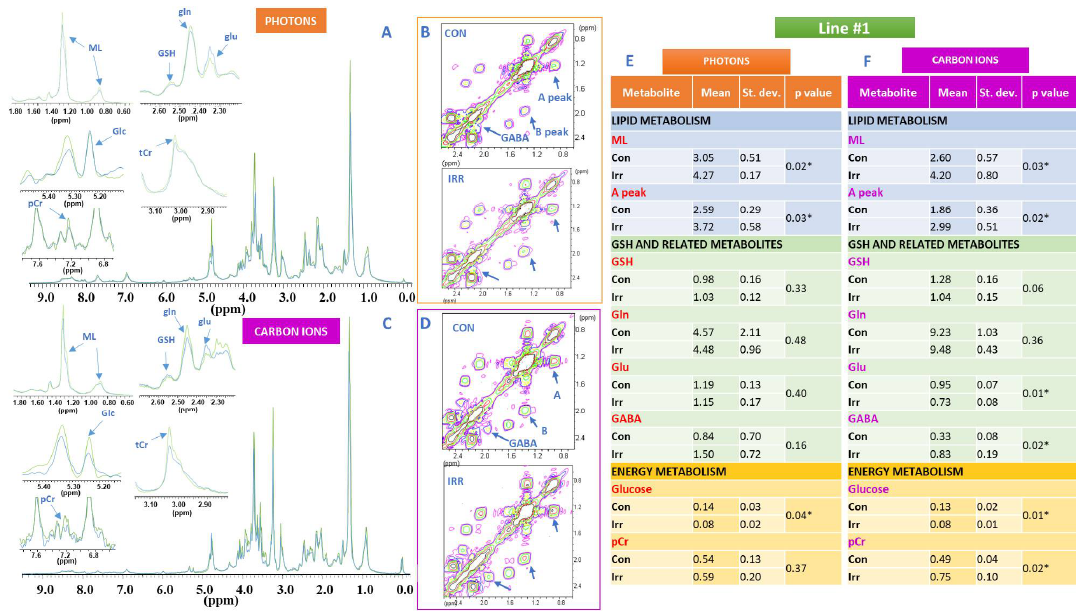
Figure 2. 1 H NMR spectra of line #1 cells, signals of interest and metabolic modifications induced by radiation treatment. ( A , B ) 1D and 2D spectra of photon beam irradiated line #1 cell samples (green trace) and corresponding controls (blue trace) together with the spectral regions of interest for the analysis: Mobile Lipids (ML, 1.28 ppm), glutathione and related metabolites (GSH 2.55 ppm, gln 2.45 ppm, glu 2.35 ppm), glucose (glc 5.22 ppm), total creatine (tCr, 3.02 ppm) and phosphocreatine (pCr, 7.25 ppm). In panel B cross peak A, arising from the correlation of CH 3 -terminal methyl group of Fatty Acid (FA) chains with the bulk of FA (excluding omega-3 FAs), at (0.89–1.28) ppm, cross peak B, representing both mono and polyunsaturated FA at (2.02–1.28) ppm and GABA cross peak at (2.30–1.90) ppm are labelled. ( C , D ) 1D and 2D spectra of carbon ion irradiated samples (green trace) at 20 Gy and corresponding controls (blue trace) of lines #1 and #83. Region of interest were expanded. All spectra were acquired 48 h after irradiation at a dose of 20 Gy with both photons and carbon ions. Assignments were performed as reported in [21]. Tables ( E ) (photon beams) and ( F ) (carbon ions) show mean values of all analyzed metabolites signal intensities, standard deviations and p values, calculated on at least 5 experiments performed 48 h after irradiation and corresponding controls. Stars indicate statistically significant variations ( p value <0.05).